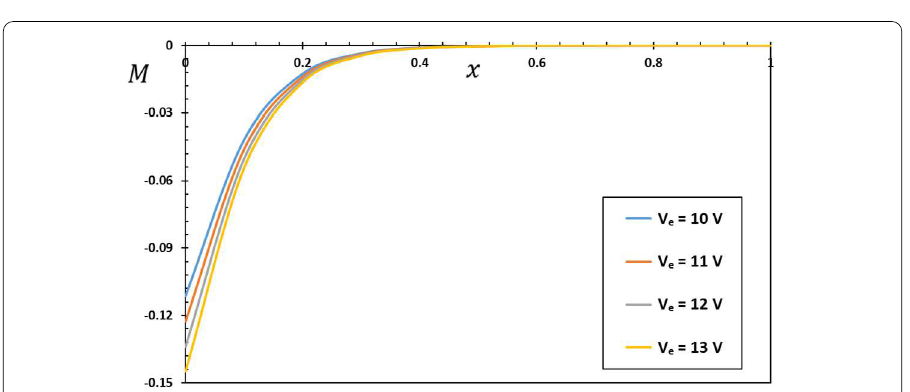
Figure 13 The effect of electric voltage V 2 e on the variation of the moment M